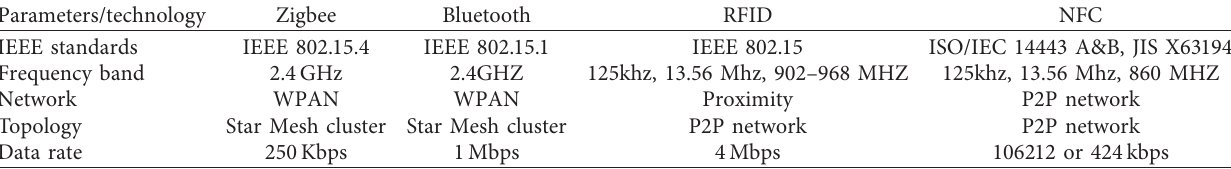
Table 5: Comparison of different communications.